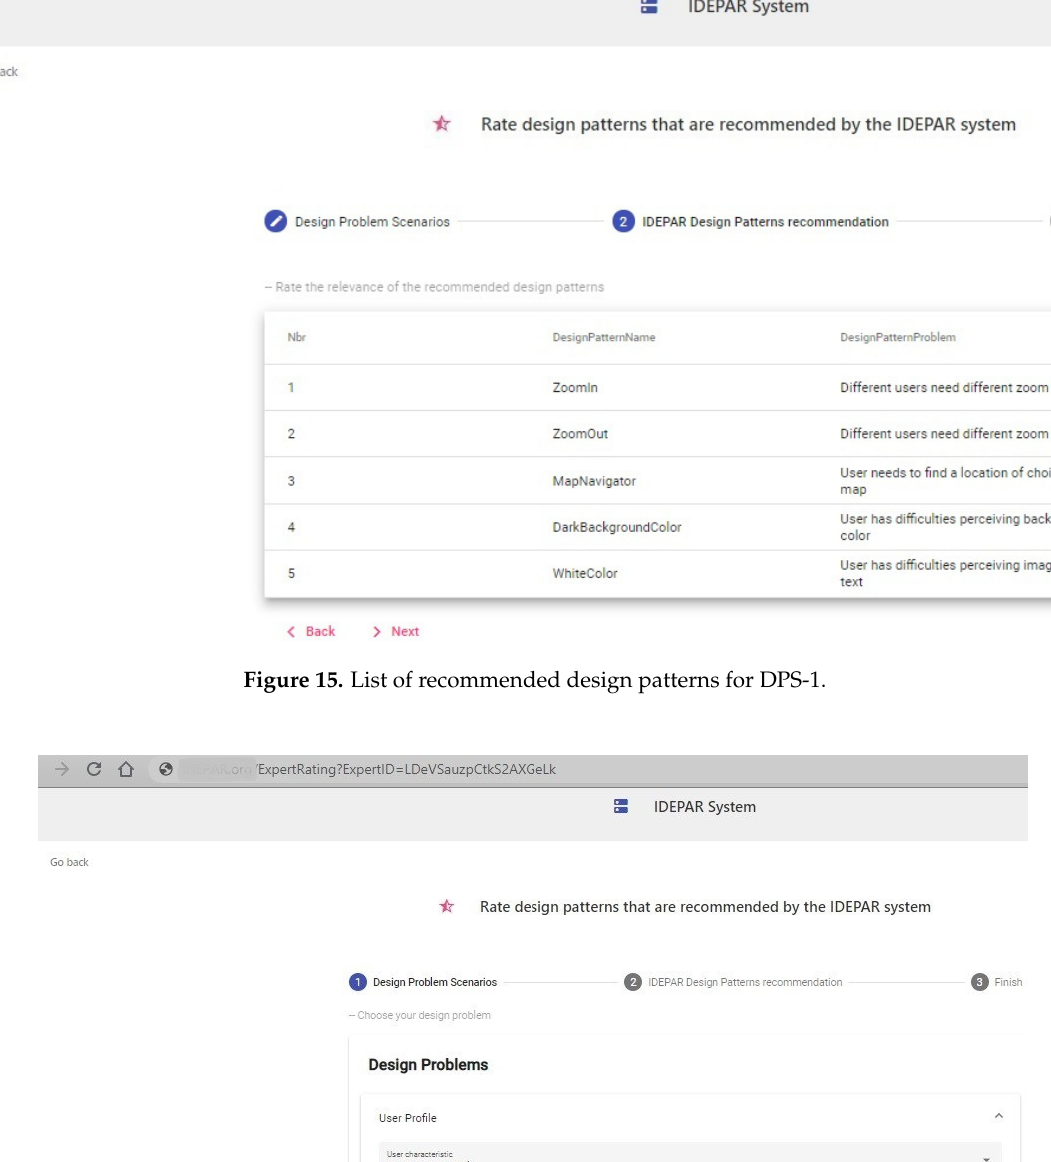
Figure 14. Selection of design problem DPS-1.